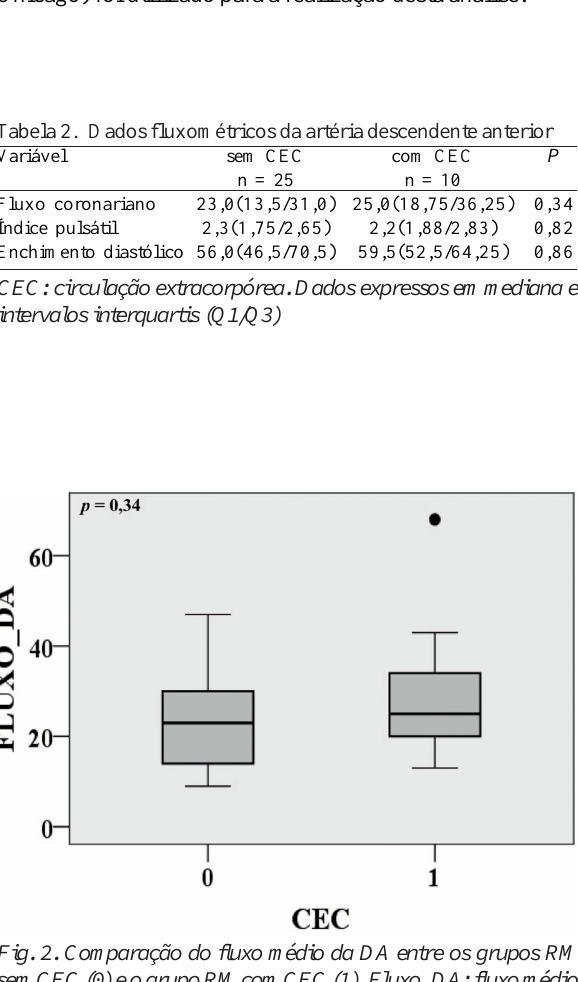
Fig. 3. Comparação do porcentual de enchimento diastólico da DA entre os grupos RM sem CEC (0) e o grupo RM com CEC (1). DF_DA: porcentual de enchimento diastólico da DA; CEC: circulação extracorpórea; RM: revascularização do